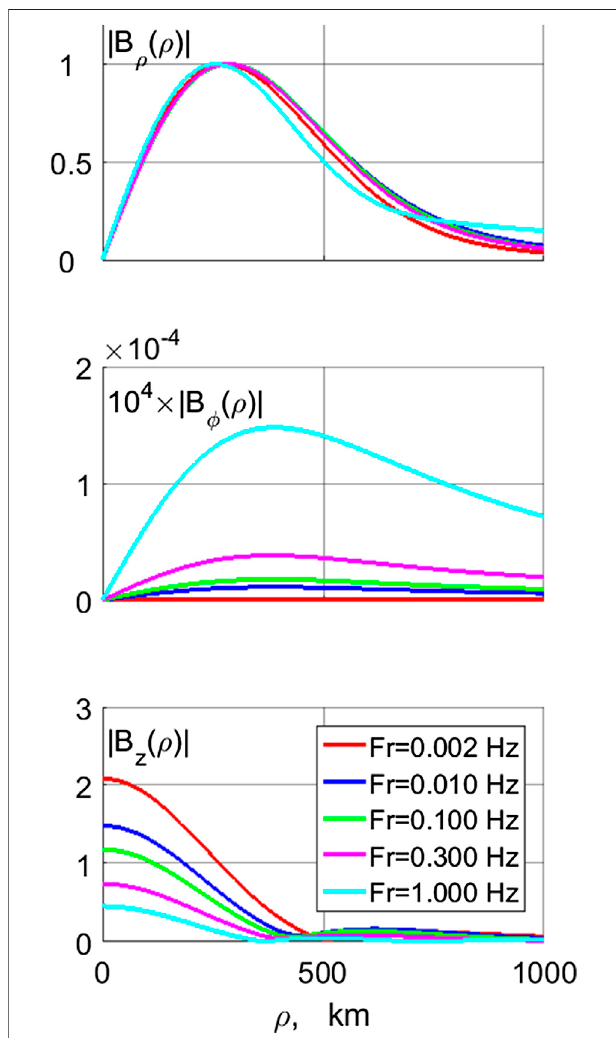
FIGURE 4 | The radial distribution of the magnetic component amplitudes (in nT),from toptobottom - B ρ ( ρ ), B ϕ ( ρ ),and B z ( ρ ),on theground for various frequencies.